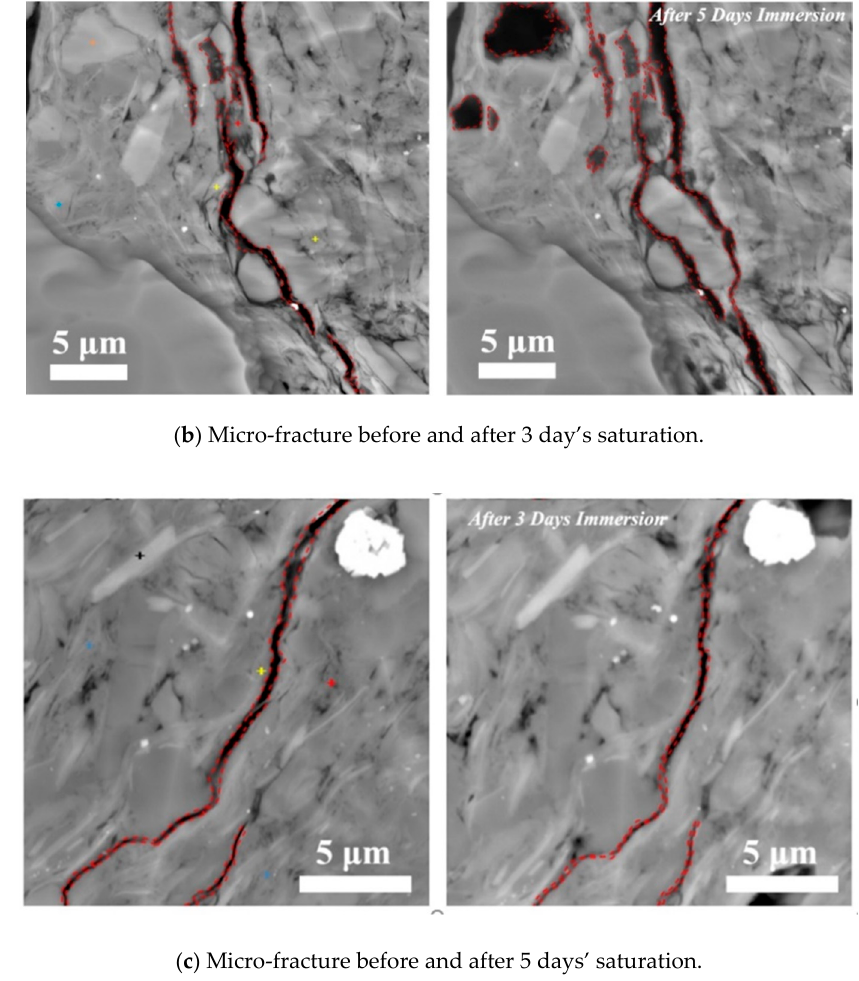
Figure 5. Micro-fracture variations before and after ( a ) 1 day’s, ( b ) 3 days’ and ( c ) 5 days’ saturation with the imbibition parallel to bedding planes at pressure of 3.5 MPa and temperature of 80 °C . The ‘+’ in figure highlights the different ions and mineral, where red is for Mg in smectite, yellow is for Fe in smectite, blue is for illite and brown is for feldspar.